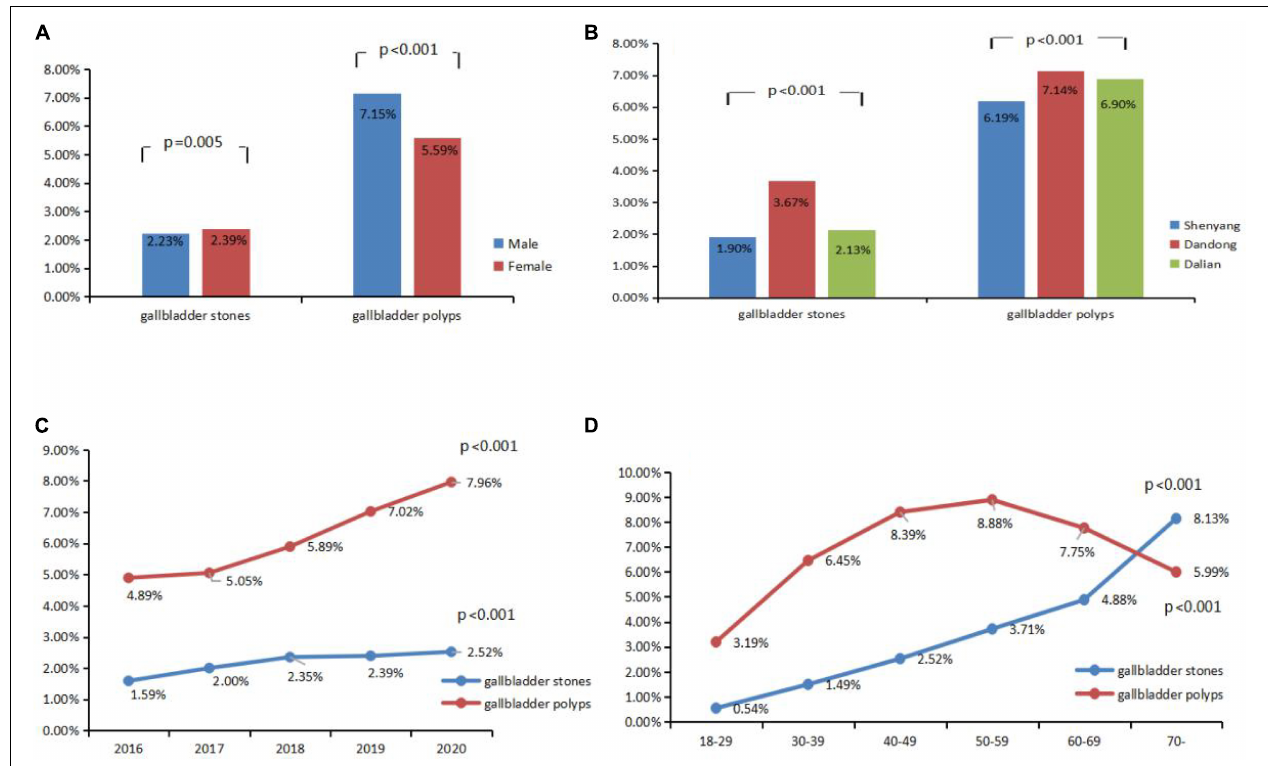
FIGURE 1 | Prevalence of gallbladder stones and gallbladder polyps stratified by different subgroups (A) gender; (B) city; (C) year; (D) age. TABLE 1 | Comparision of prevalence of gallbladder stones and gallbladder polyps between male and female stratified by different subgroups. Gallbladder stones Gallbladder